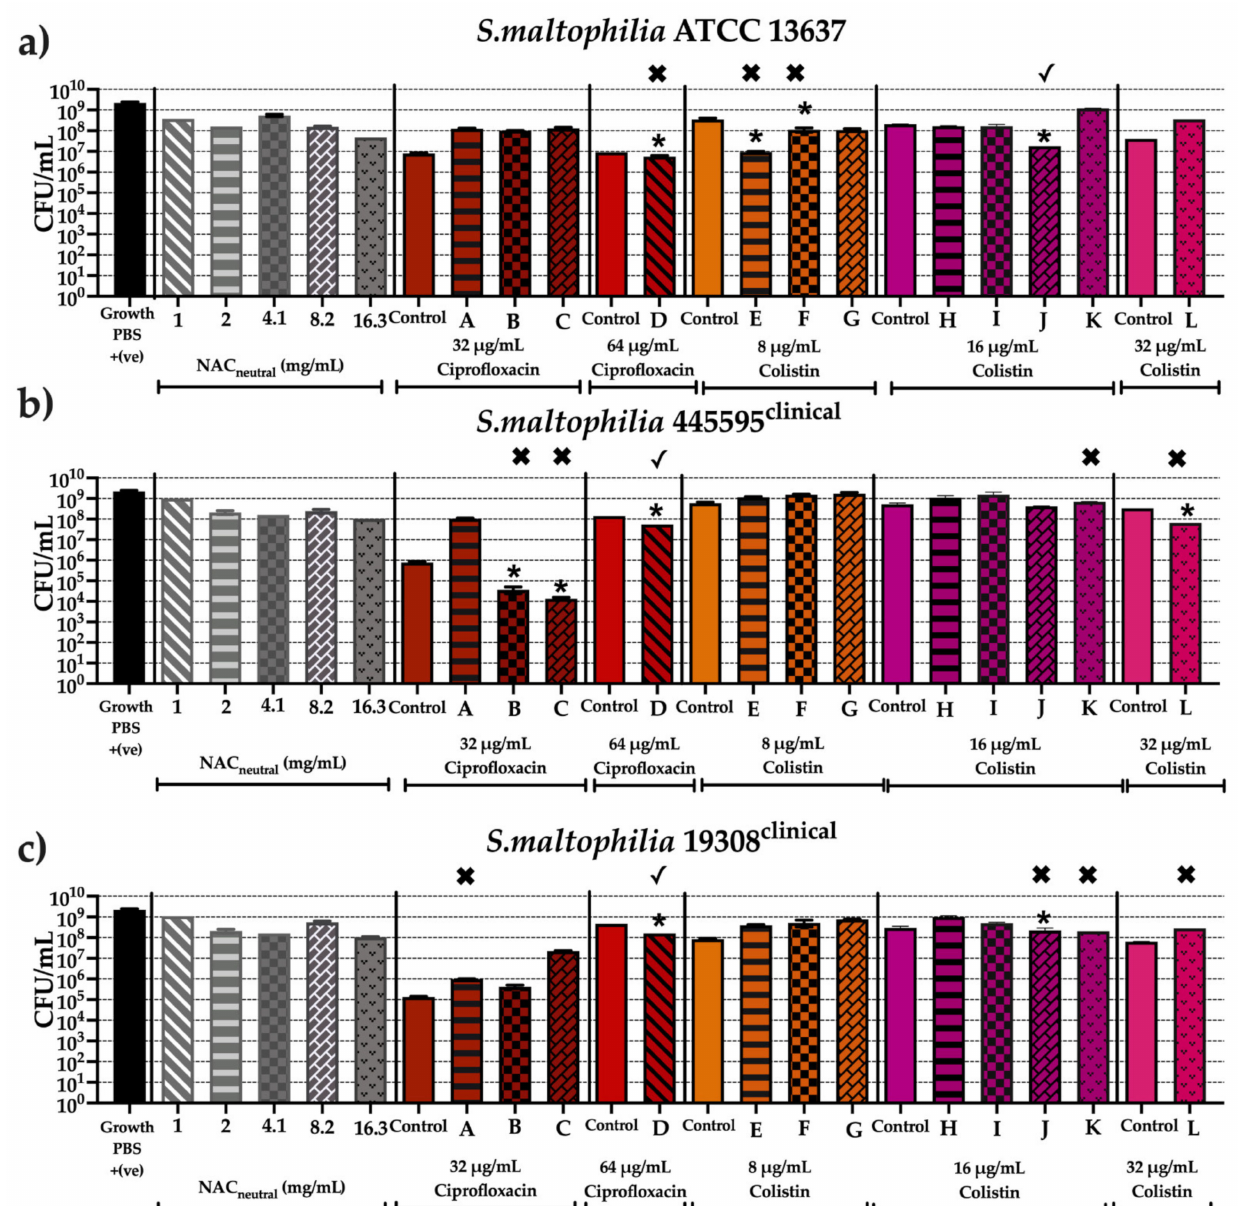
Figure 9. Anti-biofilm activity of screened combinations after 24 h against bacterial strains of S. maltophilia using colony forming units (CFU/mL). In vitro effectiveness of combination therapies (CT) (Table 3) after 24 h on following S. maltophilia strains ( a ) ATCC 13637, ( b ) 445595, ( c ) 19308. ( (cid:51) ) represents combination tested does correspond to planktonic result in FICI analysis. ( (cid:54) ) represents combination tested does not correspond to planktonic result in FICI analysis. Statistical analyses were performed using unpaired Student’s t -tests (with Welch’s correction) and multiple comparison tests (Kruskal–Wallis test with Dunn’s correction). Significance cut-offs are as p > 0.05 ( n ), p ≤ 0.05 (*). Data represent an average of n = 3 biological